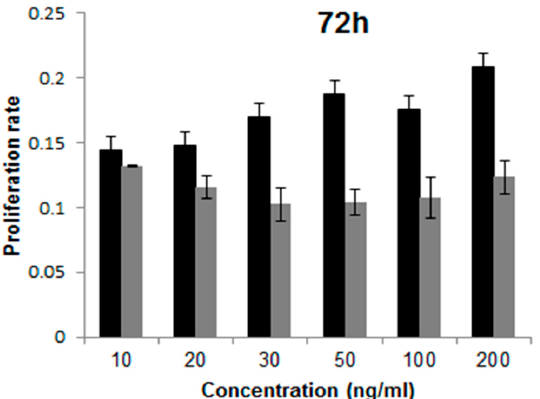
Figure 7. Proliferation analysis of H9 hESC cultured in homemade E8 medium containing either hFGF-2 (black bar) or hDJ-1 (gray bar) after ten passages.